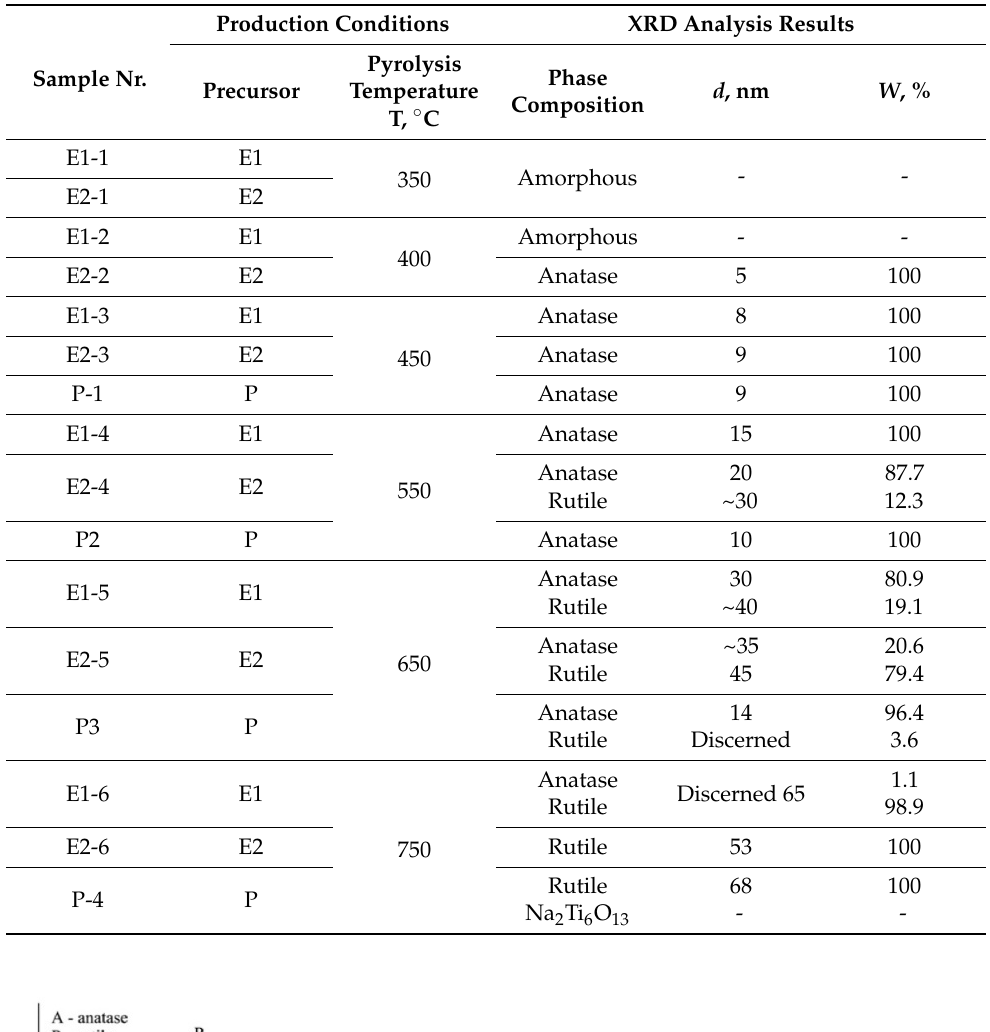
Table 1. Impact of the heat treatment conditions of titanium-containing precursors on the phase composition and mean crystallite size of the final products.